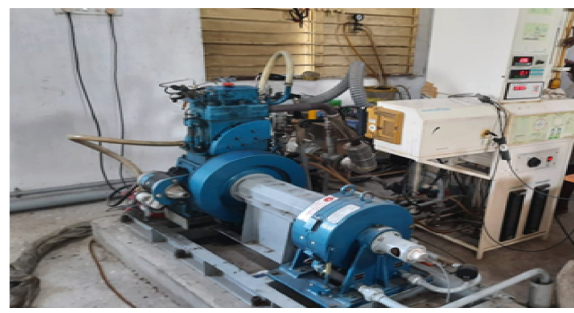
Figure 5: Test engine photographic view. Table 3: Test engine technical particulates.